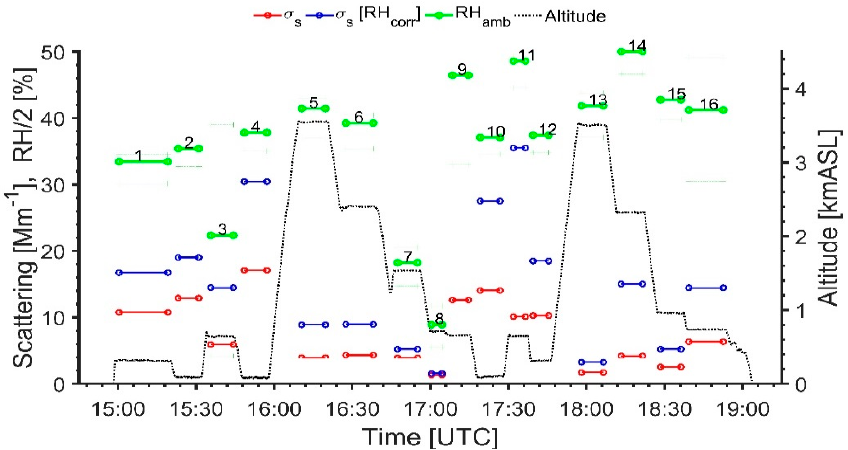
Figure 4. The same as Figure 2, except for the dry scattering coefficient measured by nephelometer (red lines), ambient scattering coefficient obtained with measured f(RH) (blue lines) at 0.55 μ m wavelength and ambient RH (green lines). FLs are labeled with numbers 1 through 16 on top of green lines.